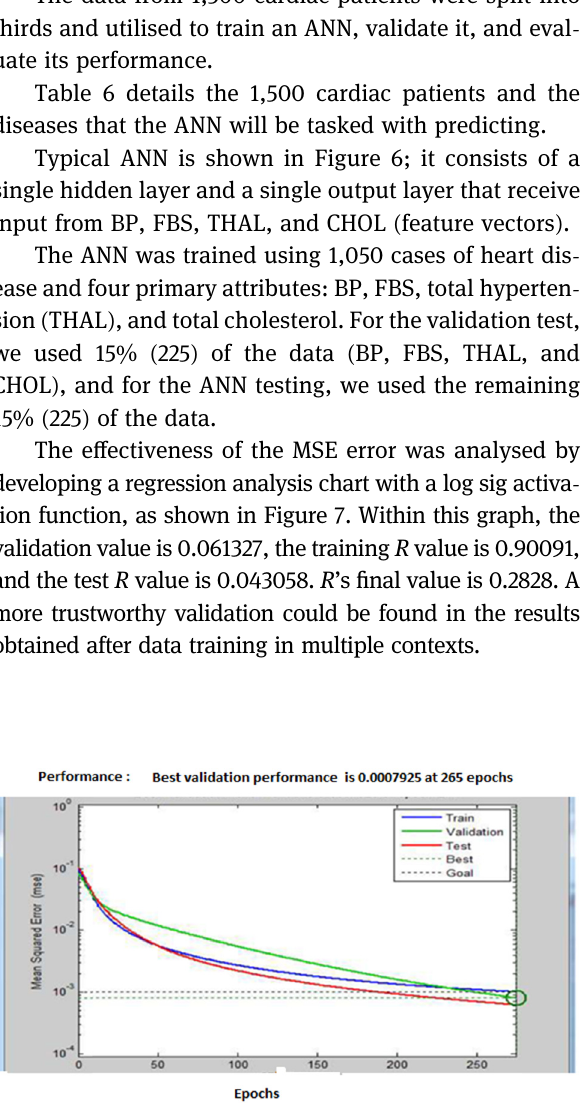
Figure 6: A typical snapshot of ANN performance